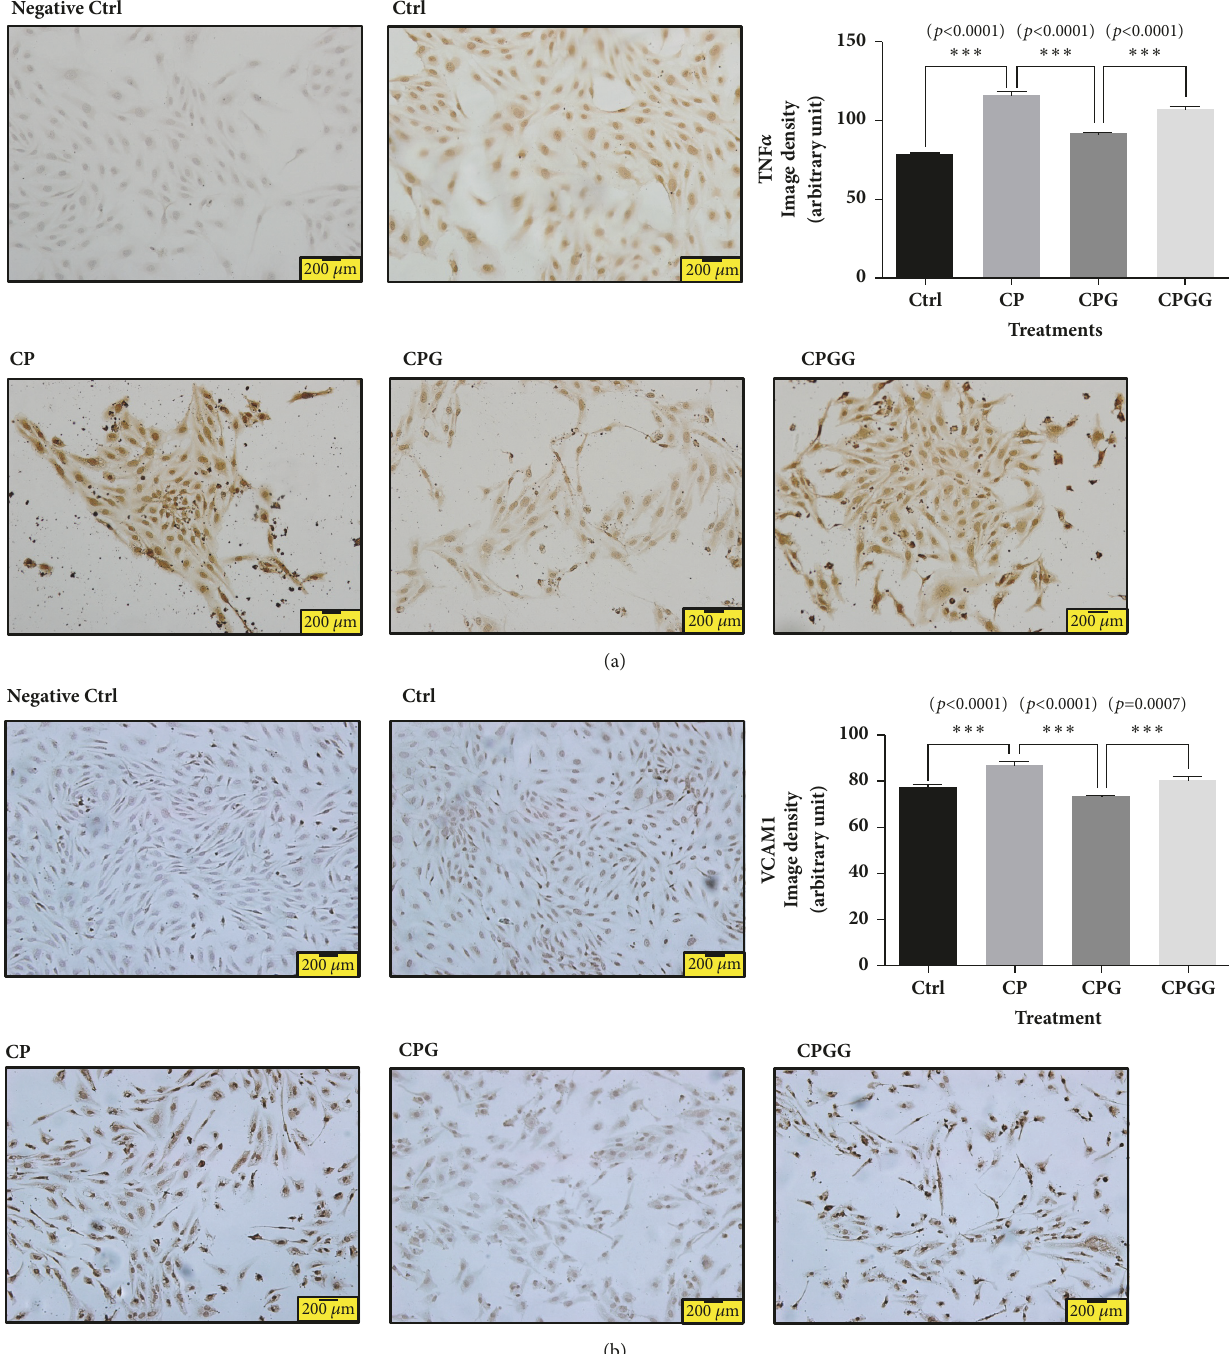
Figure 3: Imm u n o c y t o c h emistr y fo r TNF 𝛼 an d V CAM 1 in HUVE Cs treate d w it h c ho lester o l , p almitate , 6 - g in g er o l , an d GS K0660 .